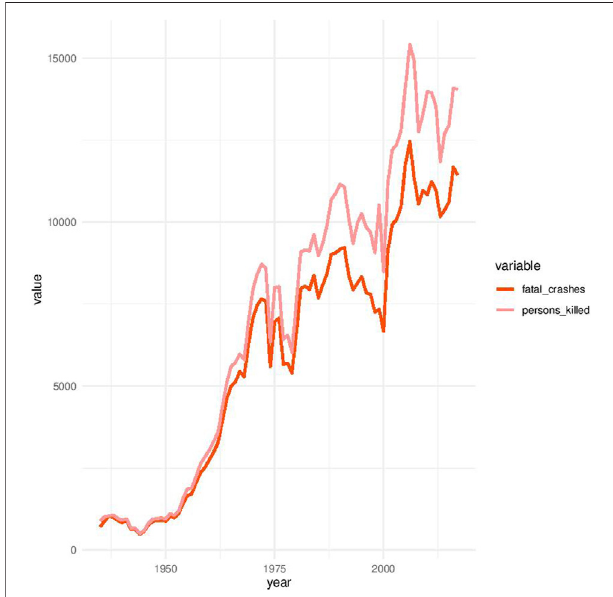
FIGURE 3 | Trends in number of fatal crashes and number of persons killed over the period 1935 – 2017 covered in this study.